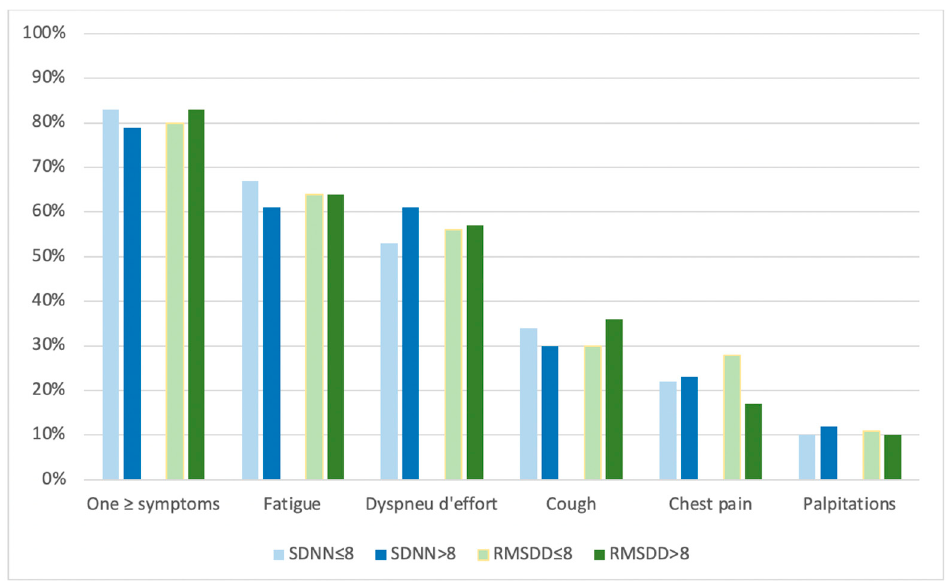
Figure 2. Symptom experience between 3 and 5 months after hospitalization for COVID-19 according to heart rate variability. Note: SDNN = standard deviation of normal to normal heartbeat intervals; RMSDD = root mean square of successive differences between adjacent heartbeats. Both SDNN and RMSSD cut-offs are in msec.